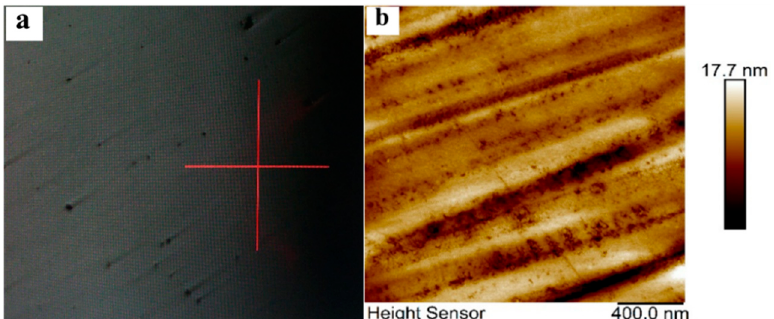
Figure 11. Micrographs of AFM images of a polished rhodochrosite surface. ( a ) Micrograph image, ( b ) two-dimensional AFM image.